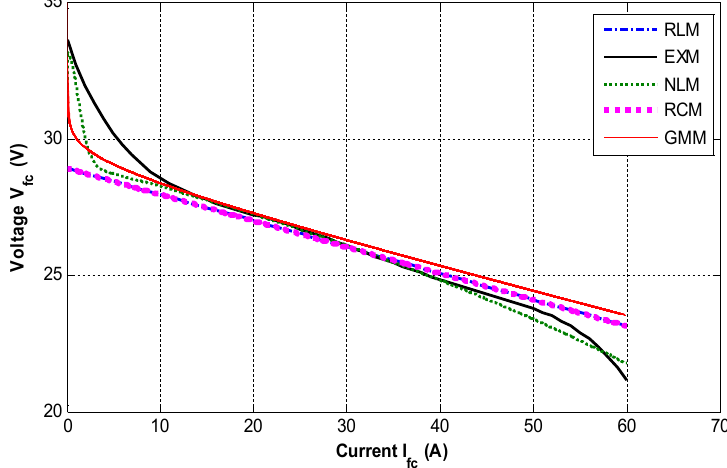
Figure 12. i–v characteristics of simulated models compared to the experiments.